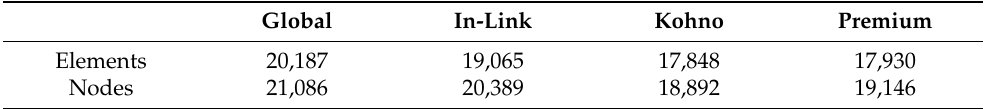
Table 2. Finite element model dimensions.